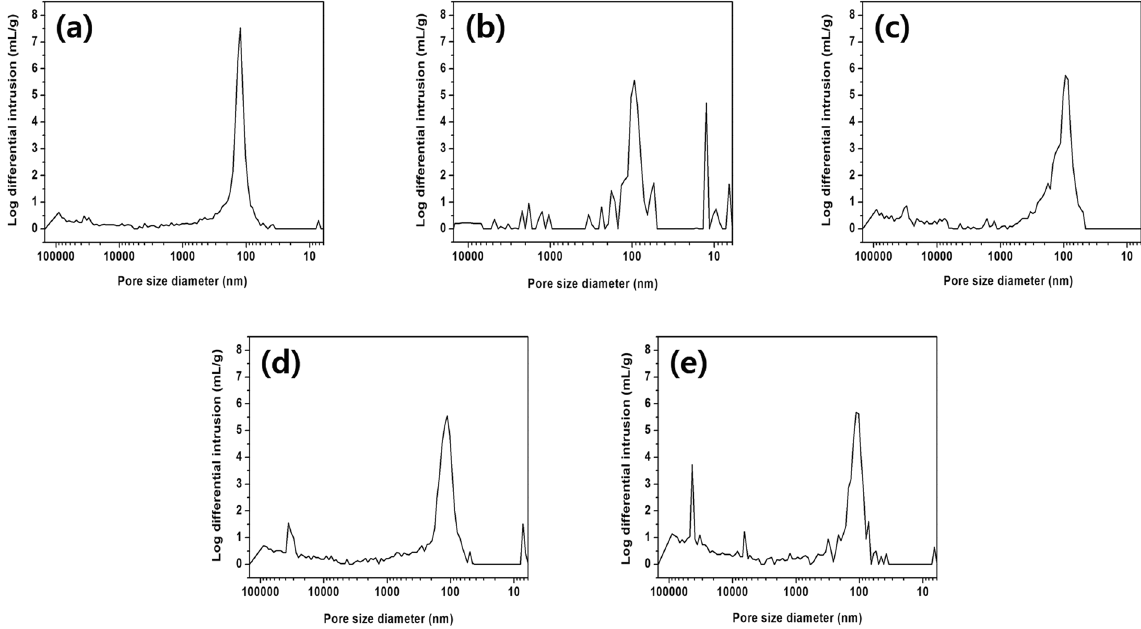
Figure 5. Porosimeter data. ( a ) Porosity in a neat cellulose acetate (CA) polymer matrix at a water pressure of 0 bar. Porosity in a 1:0.23 CA/Ni(NO